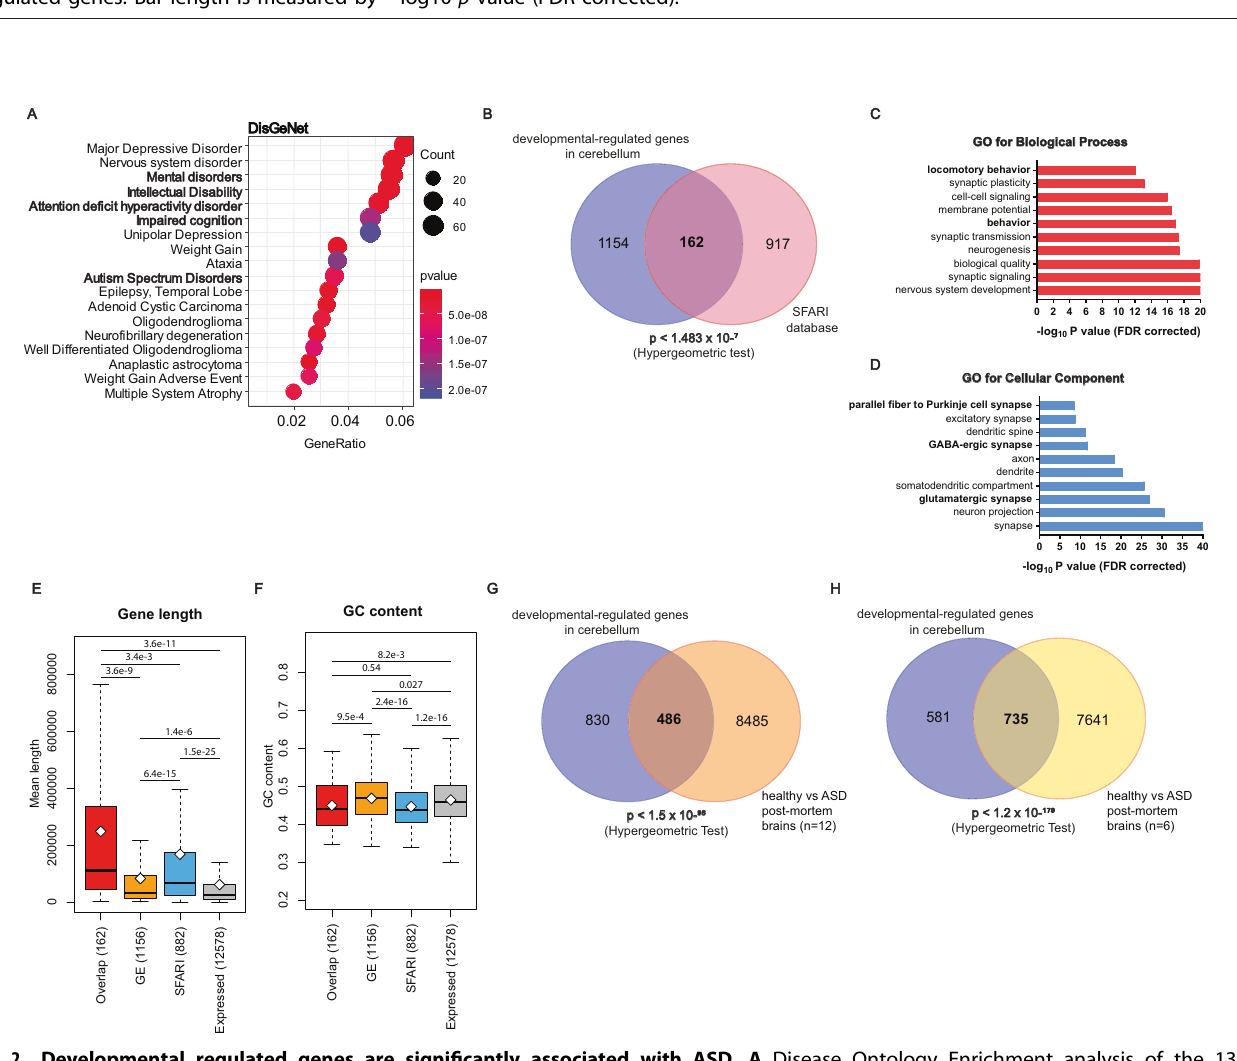
Fig. 2 Developmental regulated genes are signi fi cantly associated with ASD. A Disease Ontology Enrichment analysis of the 1316 cerebellar developmental regulated genes. The dot size in the graph is proportional to the number of genes in each category, while the dot colour represents the enrichment grade, with red indicating high enrichment score and blue indicating low enrichment score. Gene ratio is the percentage of the 1316 genes in the given GO term. B Venn diagram showing the overlap between the genes differentially expressed during cerebellar development (blue) and the genes annotated in the SFARI database (pink). The population of expressed genes in cerebellum was used as background for the statistical analysis. C , D Analysis of the Biological Processes ( C ) and Cellular Components ( D ) that are enriched among the 1316 developmental regulated genes. Bars length represents that − log10 p value (FDR corrected). E , F Boxplot representing the distribution of gene length ( E ) and GC content ( F ) among the: 162 genes regulated during cerebellum development and overlapping with SFARI database; genes regulated in the developing cerebellum ( n = 1156); genes annotated in SFARI database but not regulated during cerebellum development ( n = 882); total genes expressed in the cerebellum ( n = 12,578). Whiskers indicate 1.5 interquartile range. p Values refer to the differences between mean values and was estimated using the Student ’ s t test. G , H Venn diagrams showing the overlap between the genes differentially expressed during cerebellar development (blue) and those differentially regulated between either 12 healthy and 12 ASD post-mortem brains ( E , orange) or between 6 healthy and 6 ASD post-mortem brains ( F , yellow) in two independent by signi fi cantly lower GC content than other genes expressed in the cerebellum (Fig. 2F). However, there was no signi fi cant difference between the 162 genes undergoing dynamic changes in cerebellar development and the rest of SFARI-annotated genes (Fig. 2F). The lower GC content may be due to the larger size, as introns are generally GC-depleted with respect to exons and length of genes is generally associated with introns length [48].